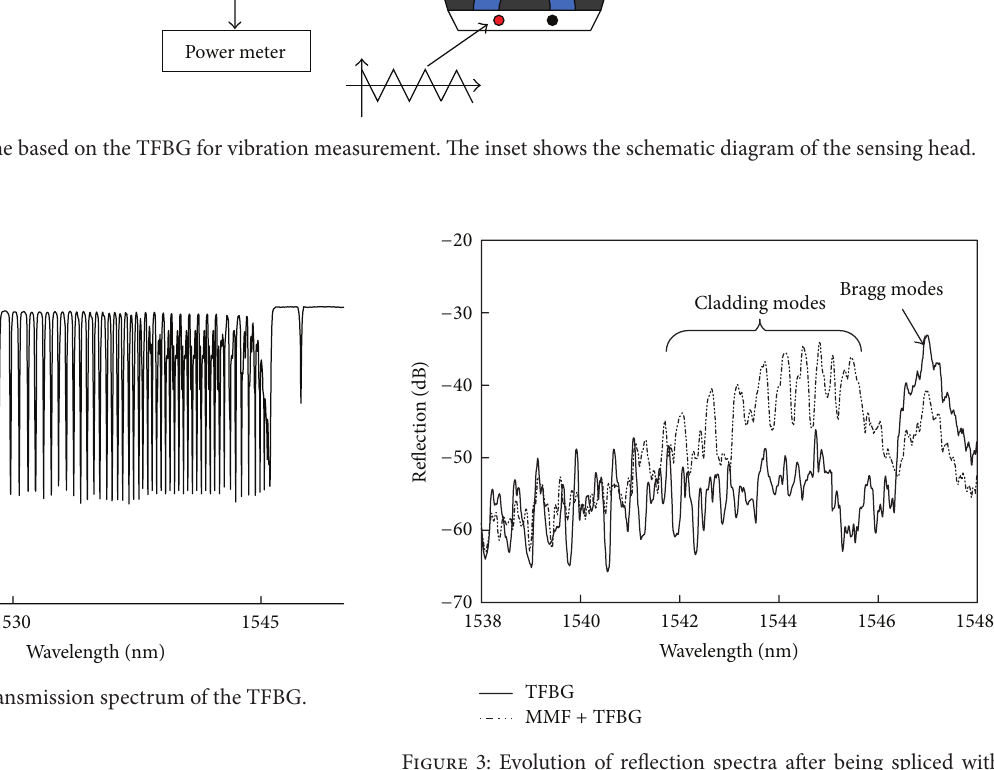
Figure 3: Evolution of reflection spectra after being spliced with